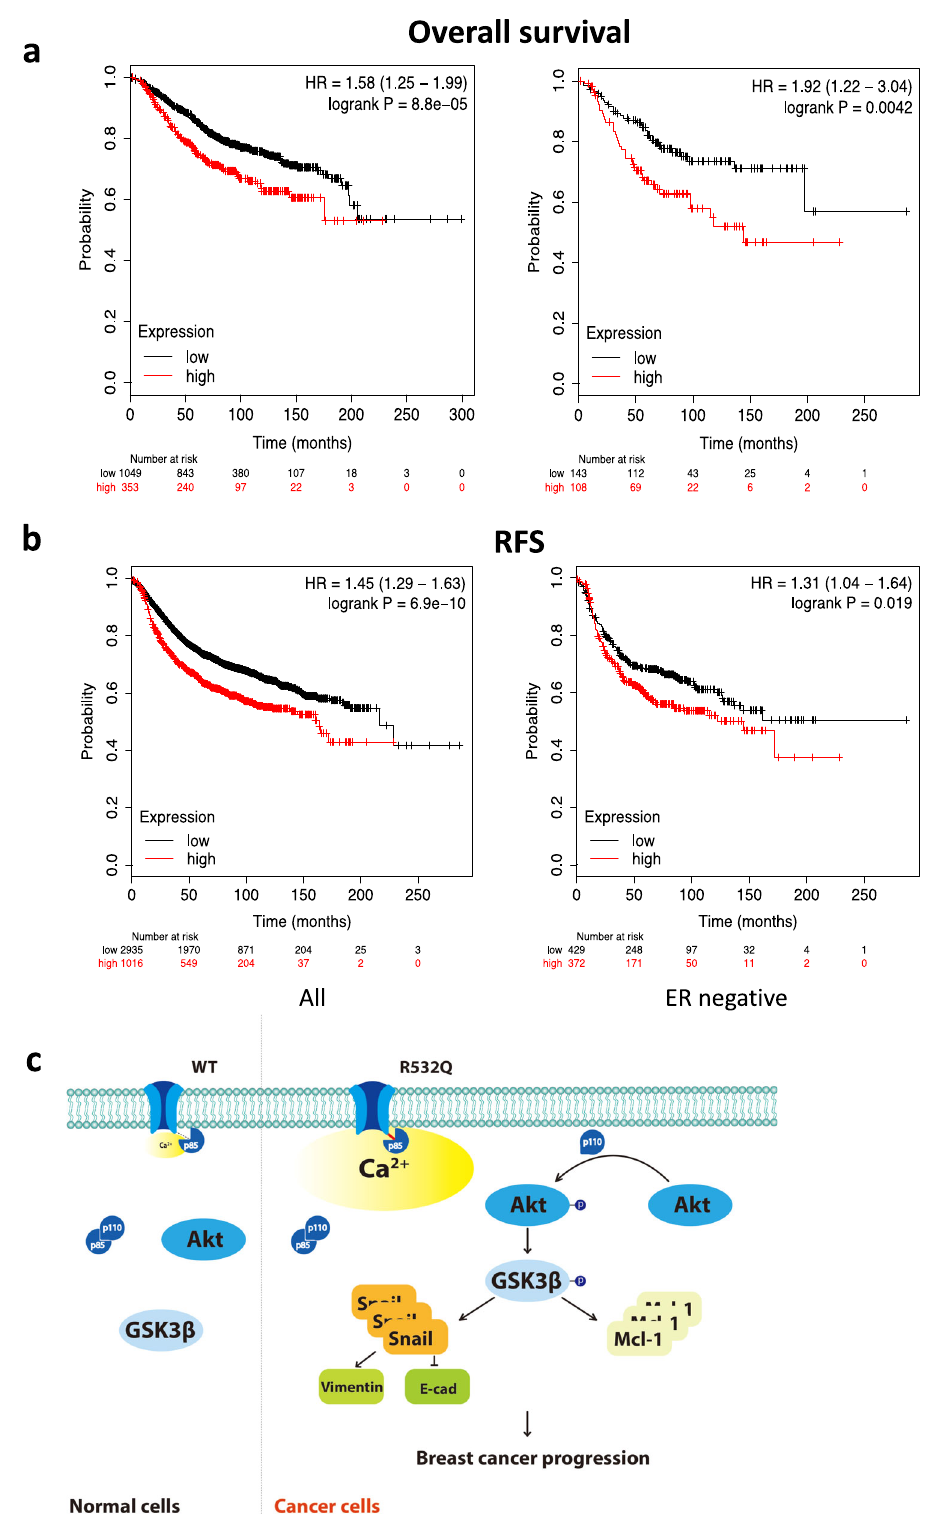
Fig. 7 Correlation between the TRPV6 gene expression and survival in breast cancer patients. Overall ( a ) and relapse-free survival (RFS). ( b ) of all types (left) or ER − (right) breast cancer patients analyzed by Kaplan – Meier plots. Hazard ratios (HR) and p values are indicated. c Diagram showing the hypothetical mechanism of how the R532Q promotes breast cancer cell progression through a PI3K/Akt/GSK-3 β pathway.